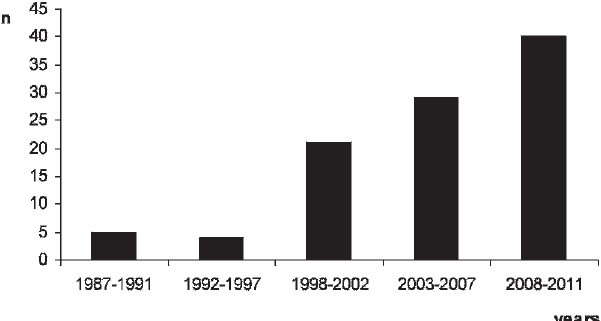
Figure 2 - Emerging recognition and surgical treatment of patients with hyperparathyroidism/multiple endocrine neoplasia type 1 at our institution.